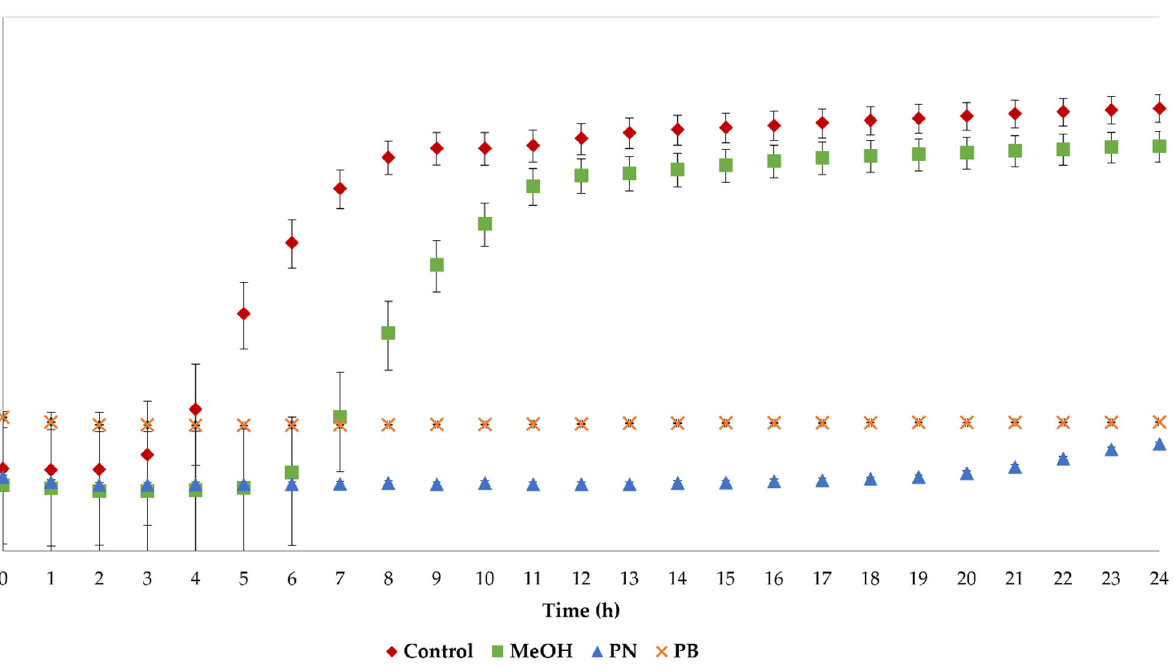
Figure 4. Antimicrobial activity of the extracts from pine needle and bark residues obtained under optimal extraction conditions.